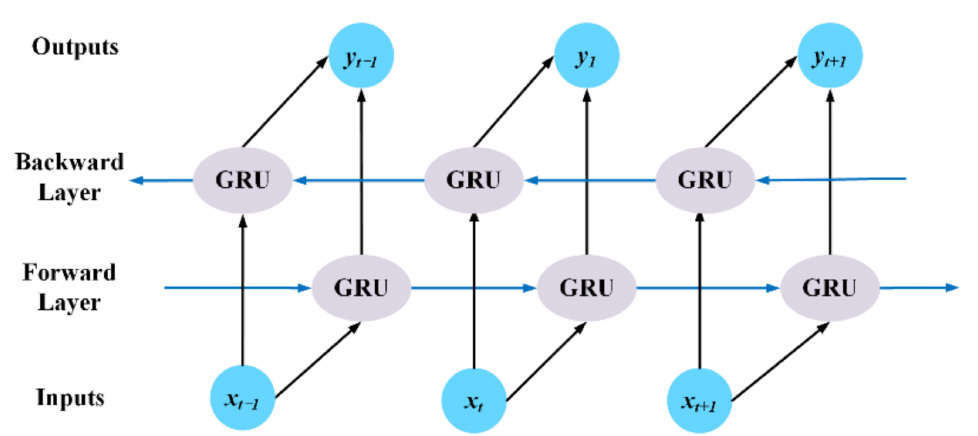
Figure 4. The basic structure of